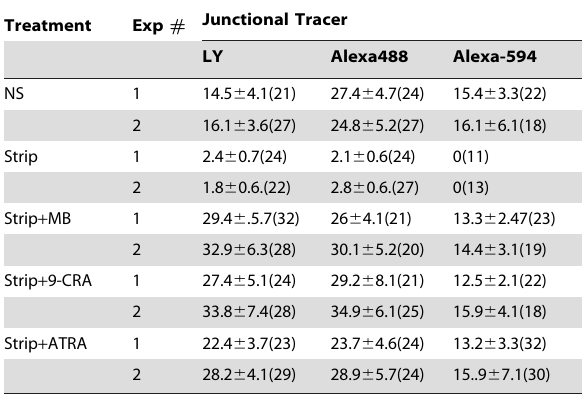
Table 2. Effect of 9-CRA, ATRA and androgen on junctional transfer in LNCaP-32 cells under androgen-depleted conditions.